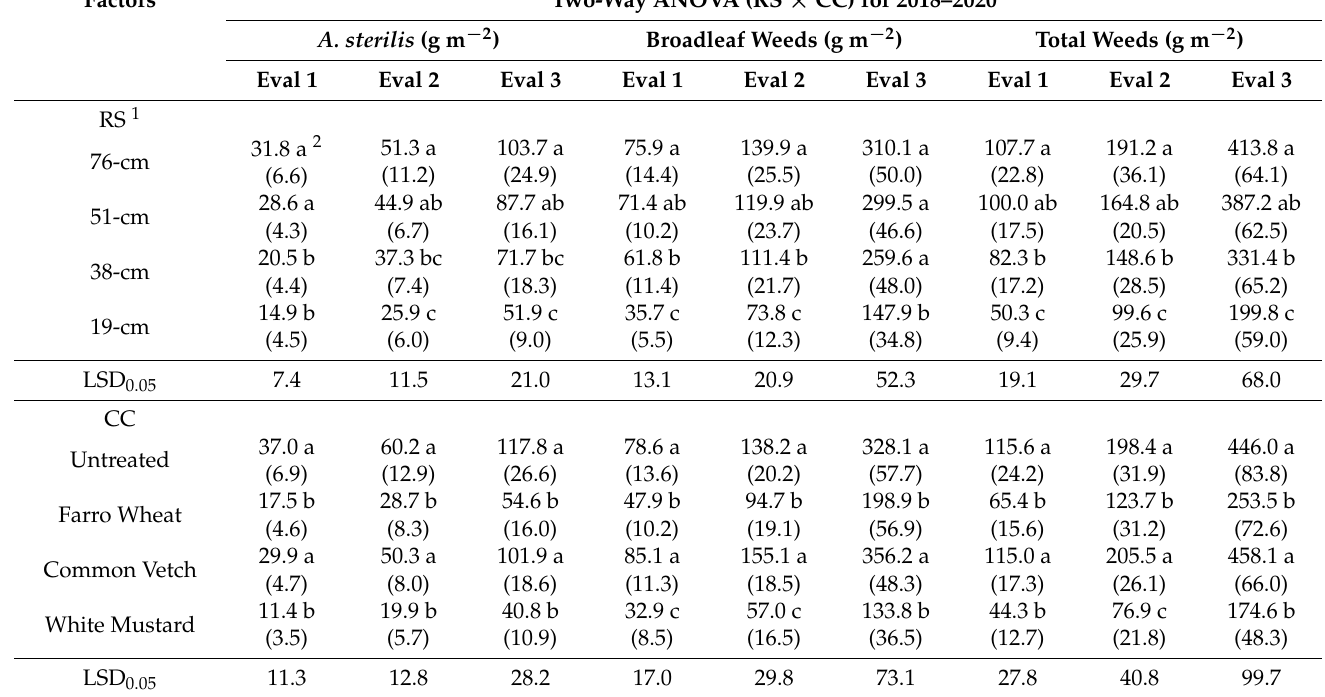
Table 3. The effects of sulla row spacing and cover crops on A. sterilis biomass (g m − 2 ), broadleaved weed biomass (g m − 2 ), and total weed biomass (g m − 2 ) in the first year of sulla growth in